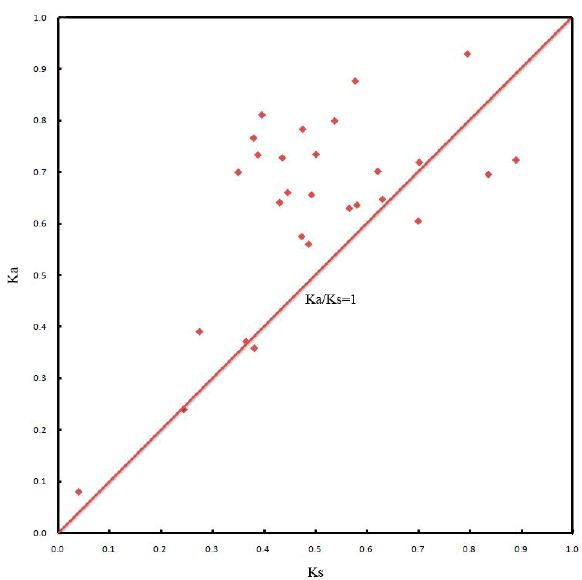
Figure 4. Chromosomal locations and gene duplication events of JcDof . Respective scaffold numbers are indicated at the top of each bar. The scale on the left is in centimorgan (cM). The JcDof gene pairs of segmental and tandem duplication are linked by pale blue lines and marked in dark blue rectangles, respectively. The detailed information of duplication pairs are described in Supplementary Table S5 .